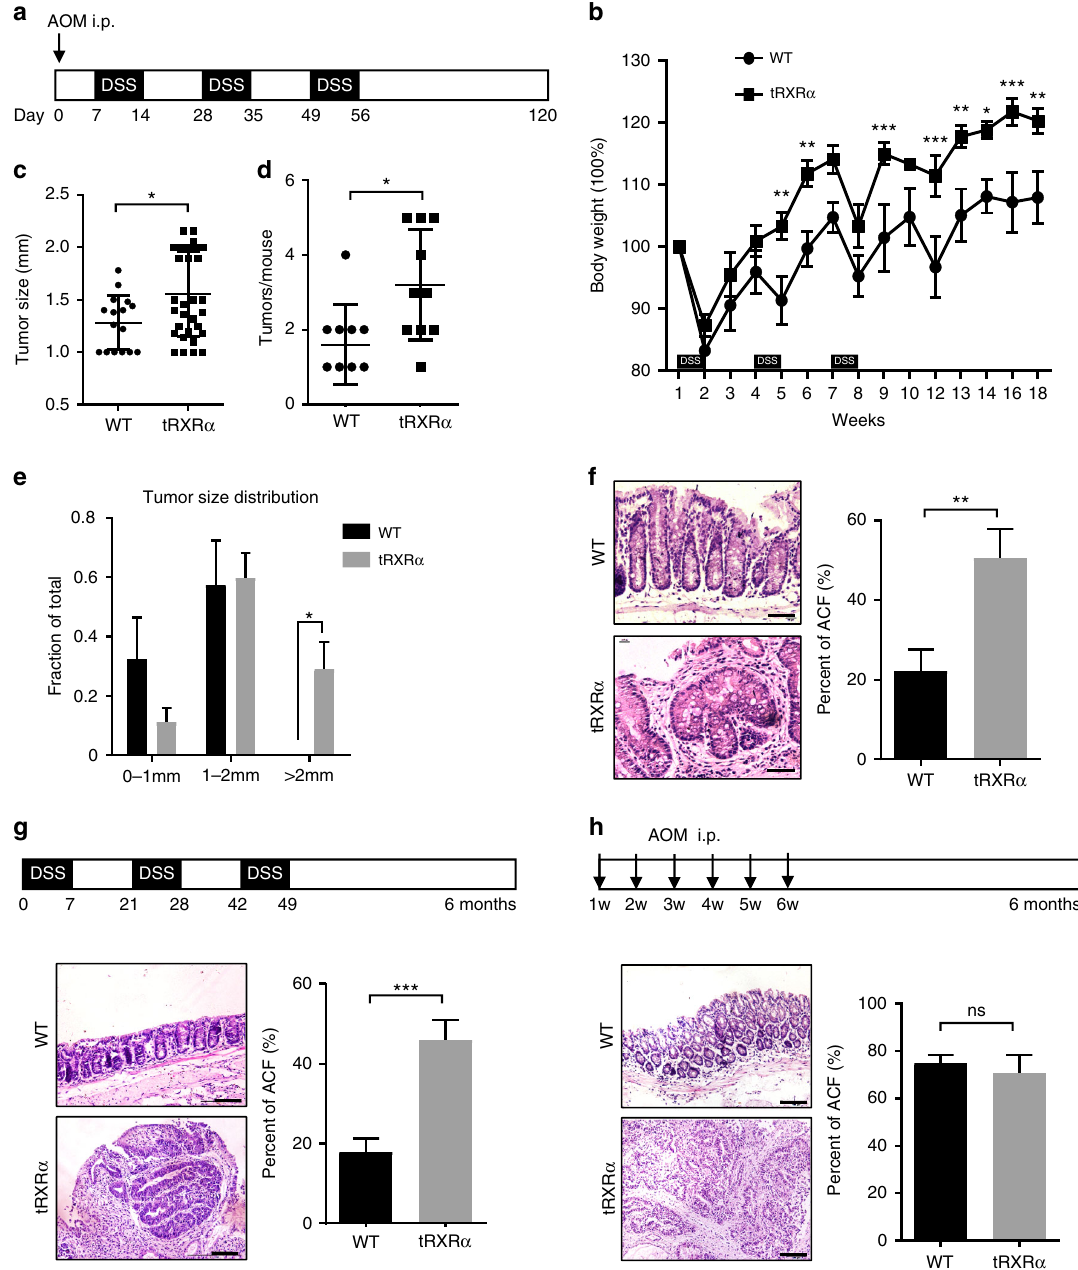
Fig. 1 Tumorigenic effect of truncated retinoid X receptor α (tRXR α ) in colitis-associated colon cancer mouse model. a Schematic representation of the azoxymethane (AOM)/dextran sodium sulfate (DSS) procedure. i.p. intraperitoneal. b Body weight curve of control wild-type (WT) and Tg-tRXR α mice during the course of AOM/DSS colitis. Data are mean ± SEM (standard error of the mean, n = 7), two-way analysis of variance (ANOVA). c Average tumor size. Each dot represents a tumor. Data are mean ± SD (standard deviation, n = 10), t test. d Average tumor number. Each dot represents the tumor number of one individual mouse. Data are mean ± SD ( n = 10), t test. e Tumor size distribution. Data are mean ± SEM ( n = 10), two-way ANOVA. f Colon tumor sections from mice treated with AOM/DSS at 120 days were microscopically analyzed and examined for microscopic aberrant crypt foci (ACF) after hematoxylin and eosin (H&E). Scale bars, 50 μ m. Data are mean ± SEM ( n = 10/8), t test. g Role of tRXR α in promoting DSS-induced colorectal carcinogenesis. Schematic representation of the 2.5% DSS procedure (top panel). Colon sections from mice treated with DSS for 6 months were microscopically analyzed and examined for microscopic ACF after H&E. Scale bars, 100 μ m. Data are mean ± SEM ( n = 10), t test. h Role of tRXR α in promoting AOM-induced colorectal carcinogenesis. Schematic representation of the AOM (10 mg/kg) procedure (top panel). Colon sections from mice treated with AOM for 6 months were microscopically analyzed and examined for microscopic ACF after H&E. Scale bars, 100 μ m. Data are mean ± SEM ( n = 6); ns not signi fi cant. * P < 0.05, ** P < 0.01, *** P <